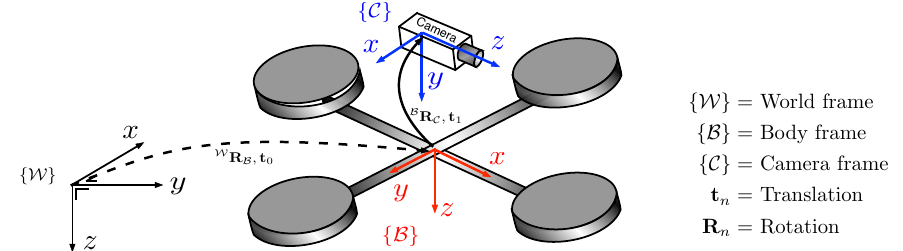
Figure 2. Coordinate systems: body , world , and camera . Transformation {B} {W} {C} between and is constant whereas varies as the quadrotor moves. C R rotates a B {B} {C} {B} vector defined with respect to to a vector with respect to {B} {C}